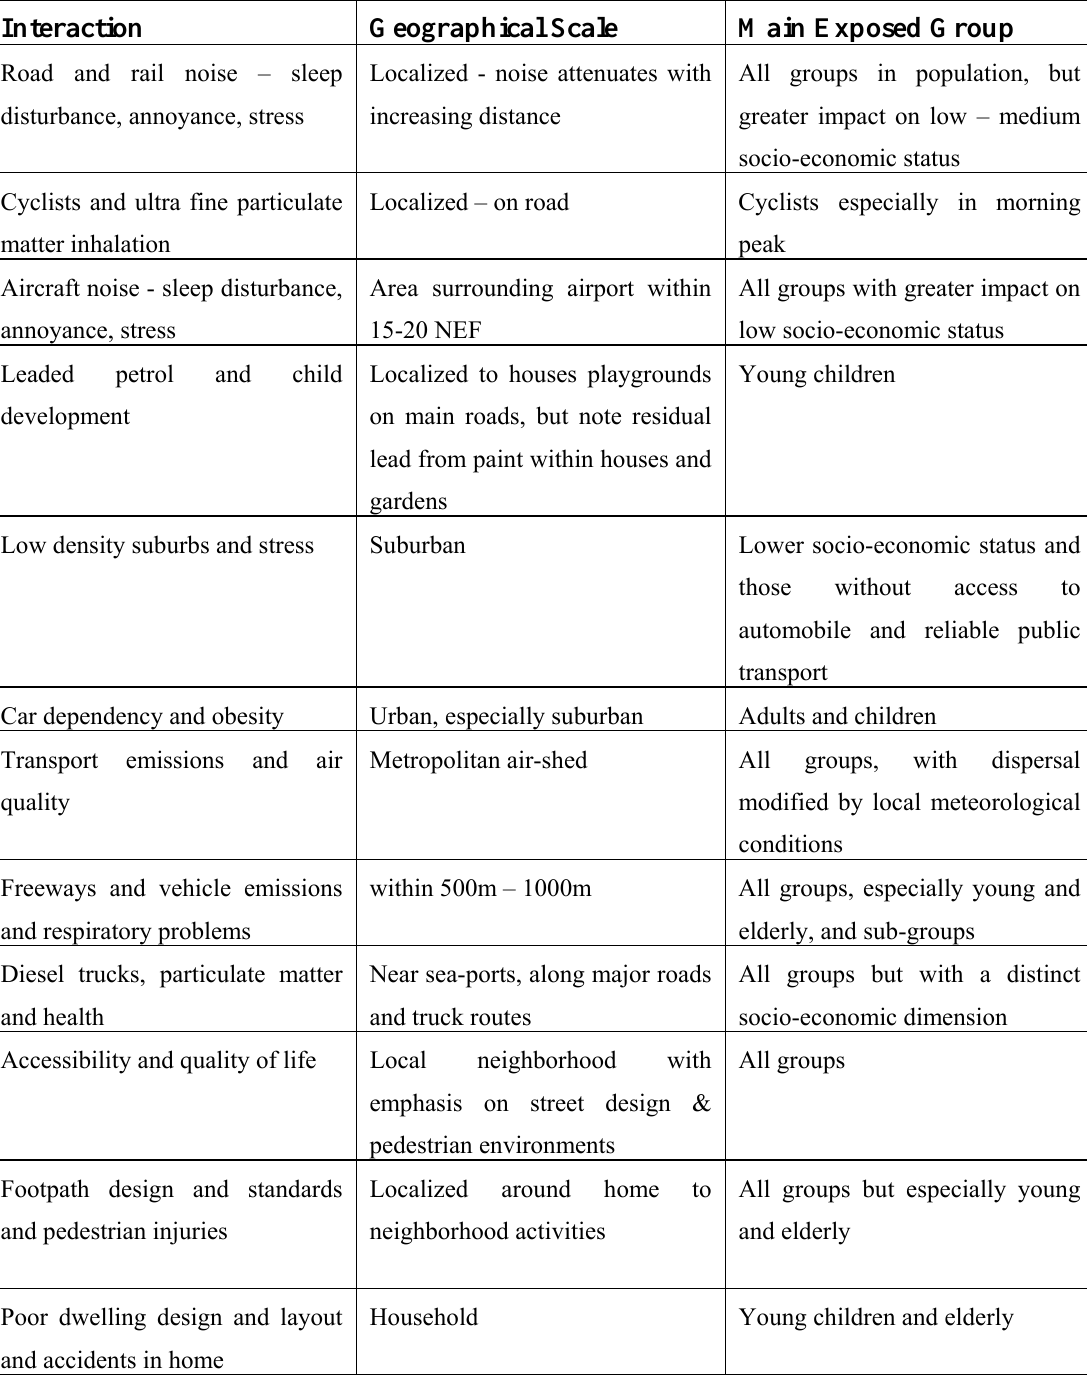
Table 3. Built Environment Impacts on Health and Geographical Scale of